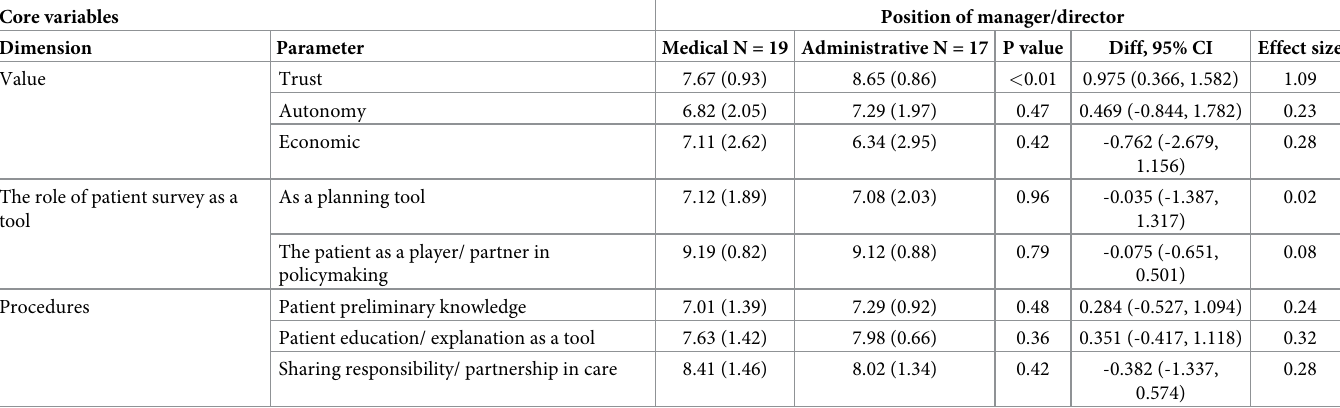
Table 2. Survey core variables by type of provider and role/position